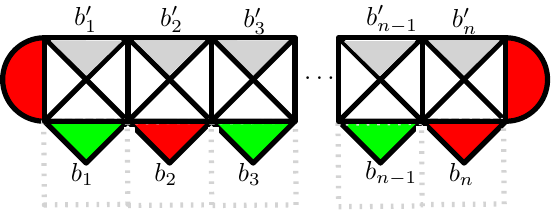
Figure 6. A row R i of R , denoted by R i , with an assignment of values to the program